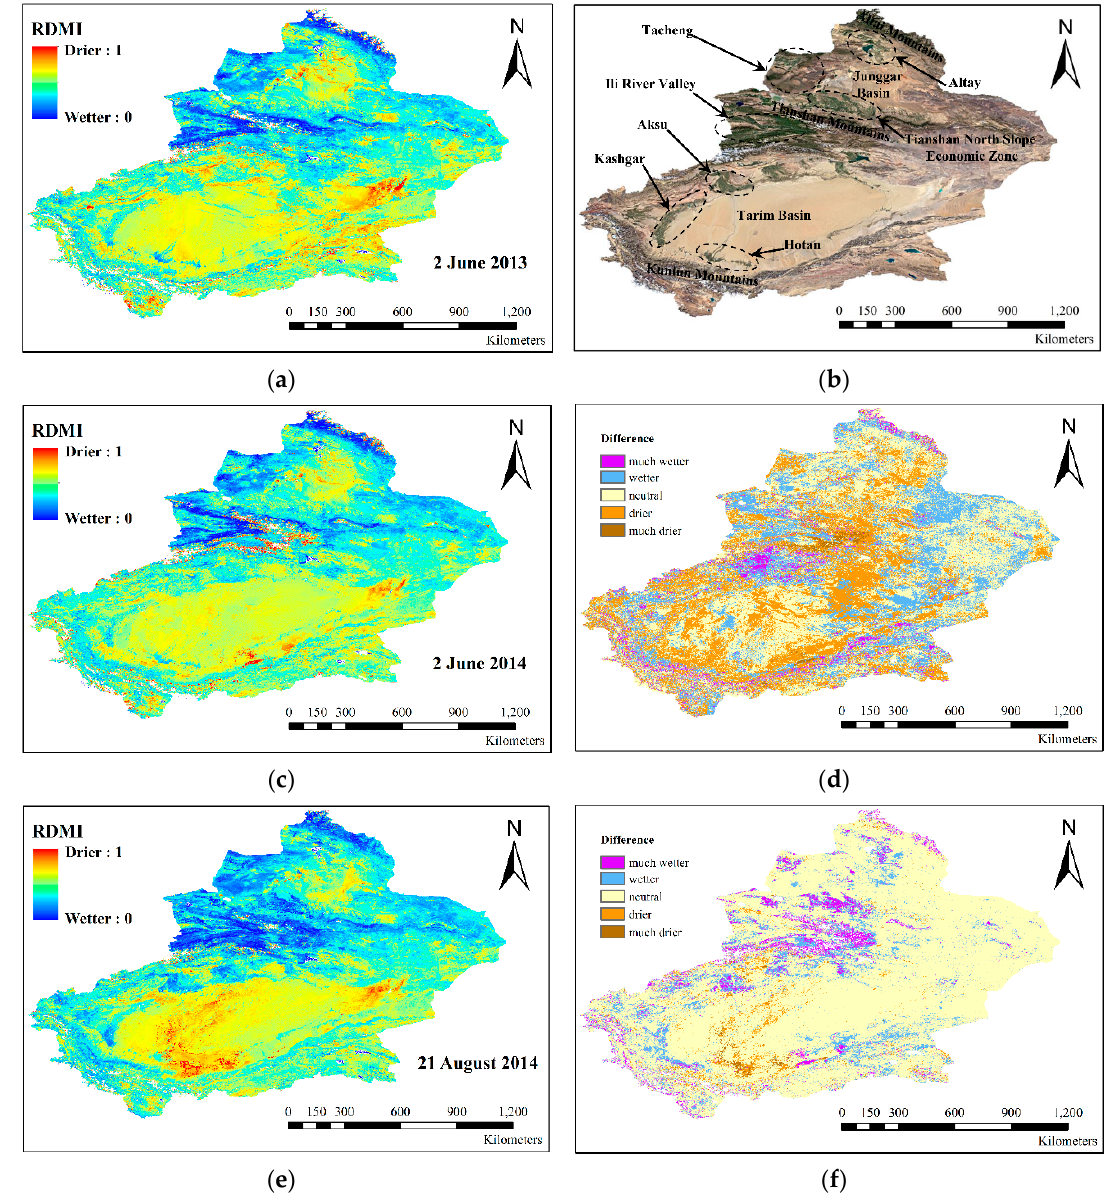
Figure 14. The RDMI maps of the Xinjiang province and the differences in dryness in spatial distributions. ( a ) RDMI map for June 2, 2013; ( b ) illustration of the Xinjiang area; ( c ) RDMI map for June 2, 2014; ( d ) the RDMI difference on the same date of different years; ( e ) RDMI map for August 21, 2014; ( f ) the RDMI difference on the different date of the same year.